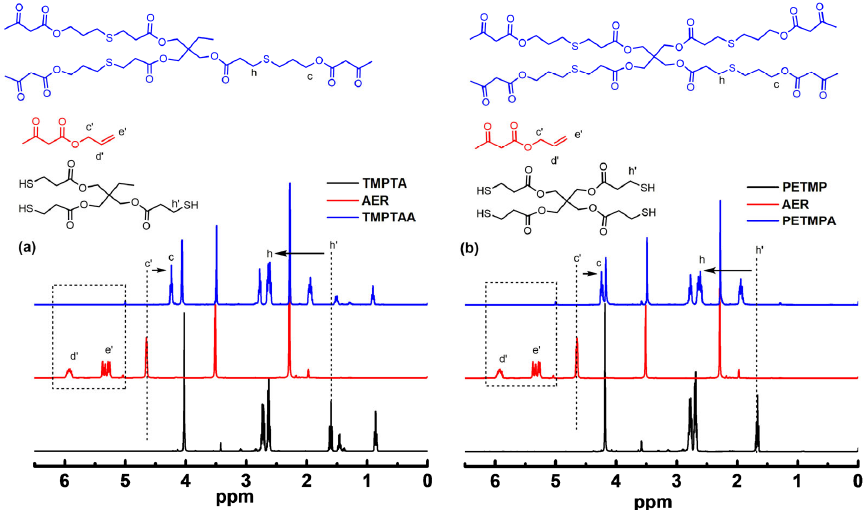
Figure 1. ( a ) 1 H NMR of TMPTA, PETMP, allyl acetoacetate and TMPTAA, ( b ) 1 H NMR of TMPTA, PETMP, allyl acetoacetate and PETMPA.